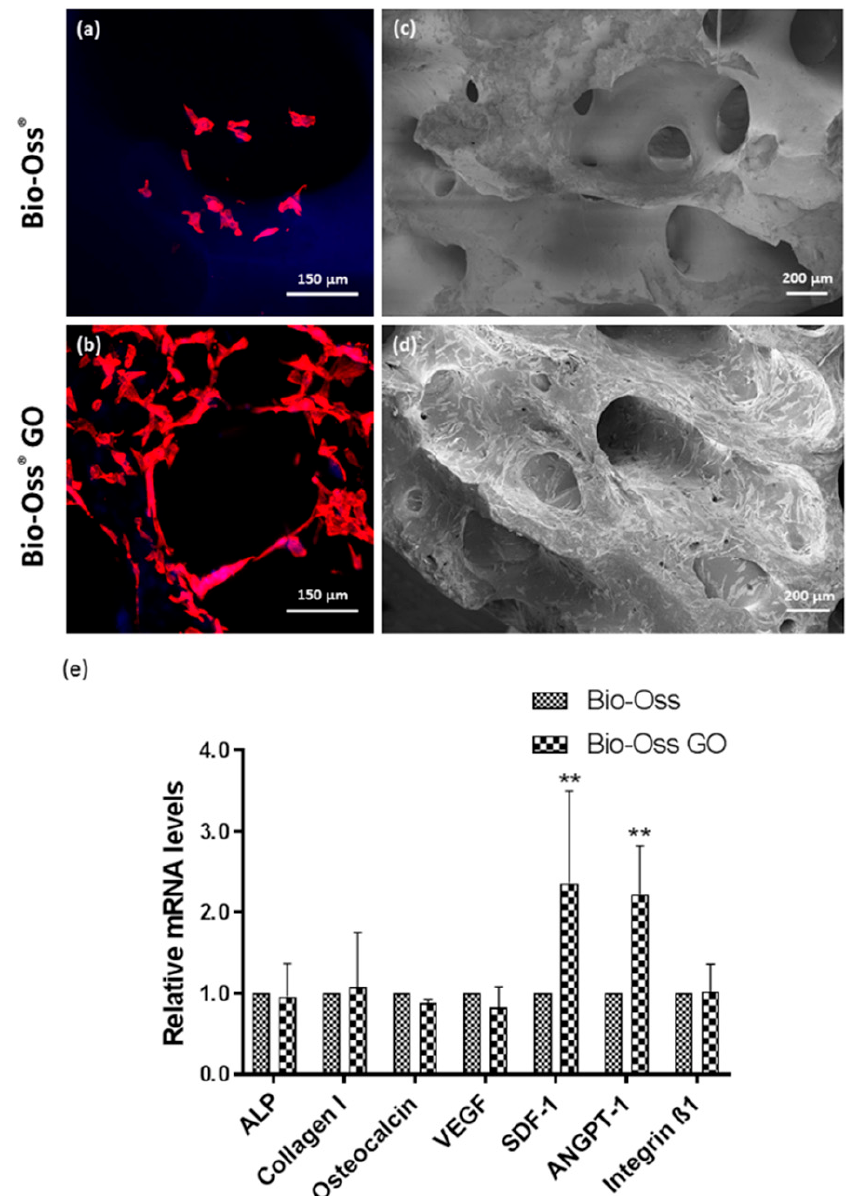
Figure 5. Growth of MSC on GO coated Bio-Oss ® . ( a , b ) MSC mono-cultures on Bio-Oss ® ( a ) and GO coated Bio-Oss ® scaffolds ( b ) on day 7 visualized by confocal laser scanning microscopy. Cells were stained with Phalloidin-TRITC (red) and Höchst (blue). ( c , d ) SEM micrographs of MSC mono-culture on Bio-Oss ® ( c ) and GO coated Bio-Oss ® ( d ) scaffolds on day 7. ( e ) Relative gene expression of the osteogenic markers and cell-matrix adhesion molecule integrin evaluated by semi-quantitative RT-PCR for MSC mono-cultures on Bio-Oss ® and GO coated Bio-Oss ® scaffolds on day 7. Two-way ANOVA, ** p < 0.01, n = 3